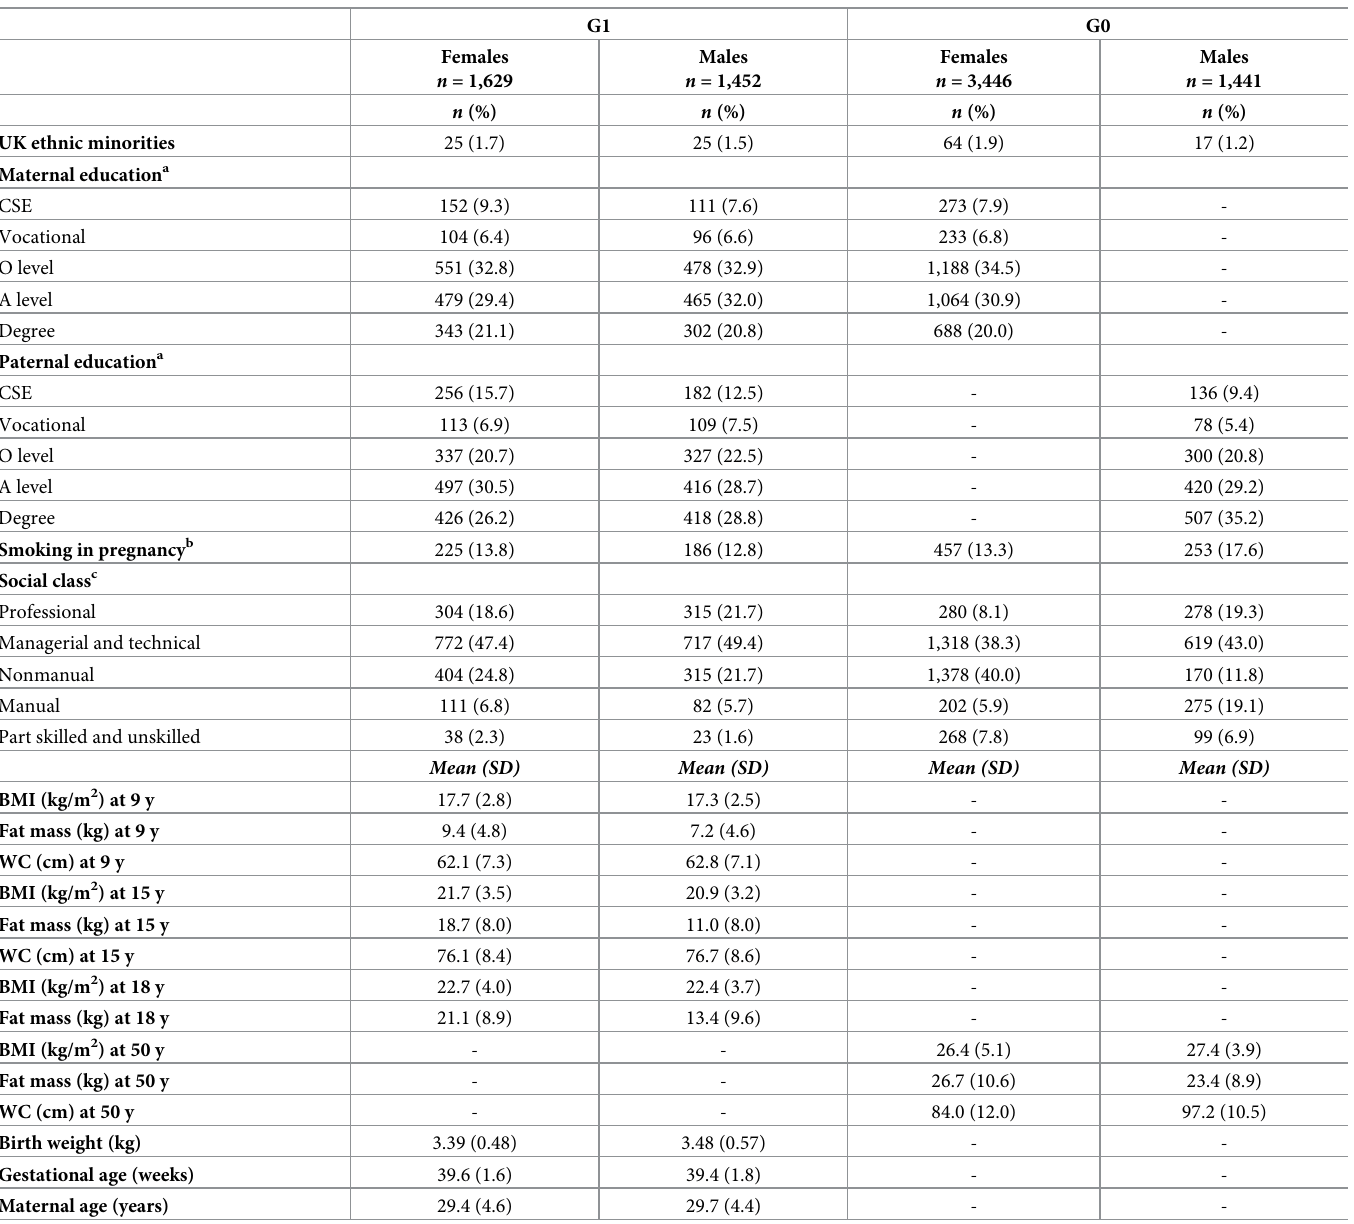
Table 1. Characteristics of participants included in analyses by